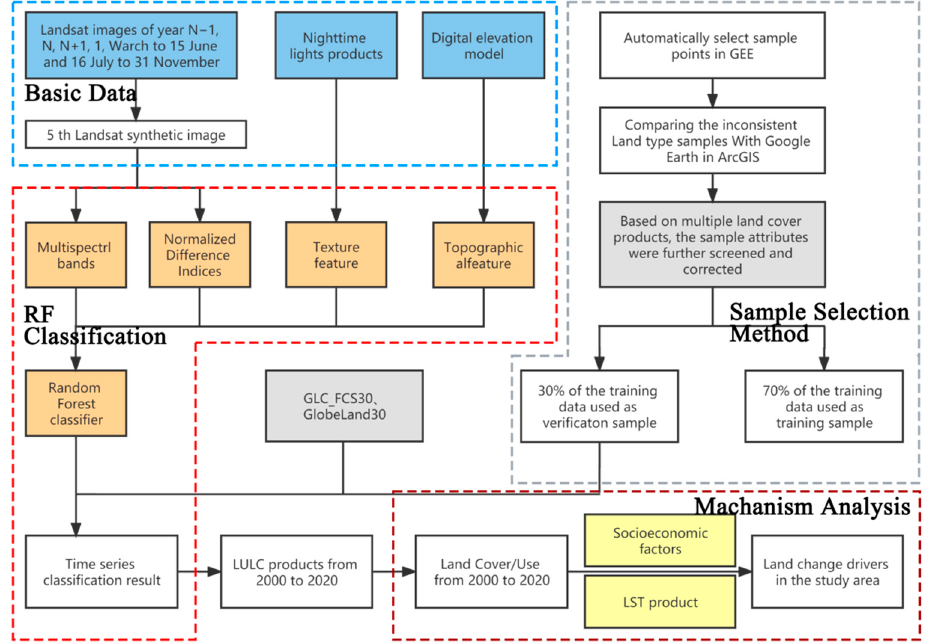
Figure 2. Flowchart of land cover mapping and mechanism analysis. Land cover mapping includes sample selection, basic data, and RF classification. Table 3. The selected Landsat image collections for the study area. Satellite